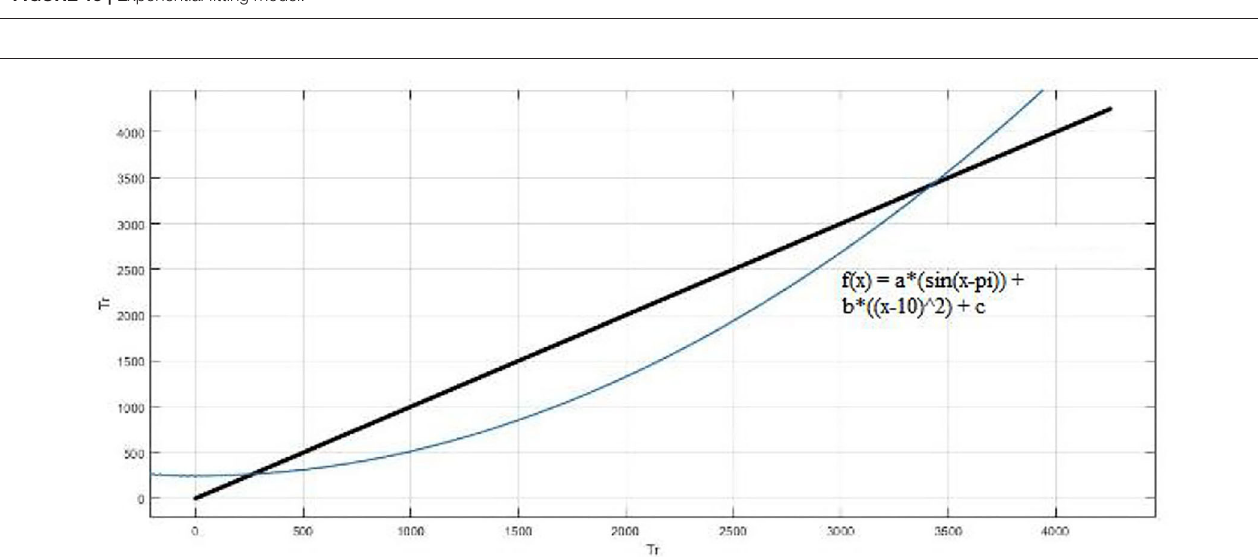
FIGURE 14 | Gauss fitting